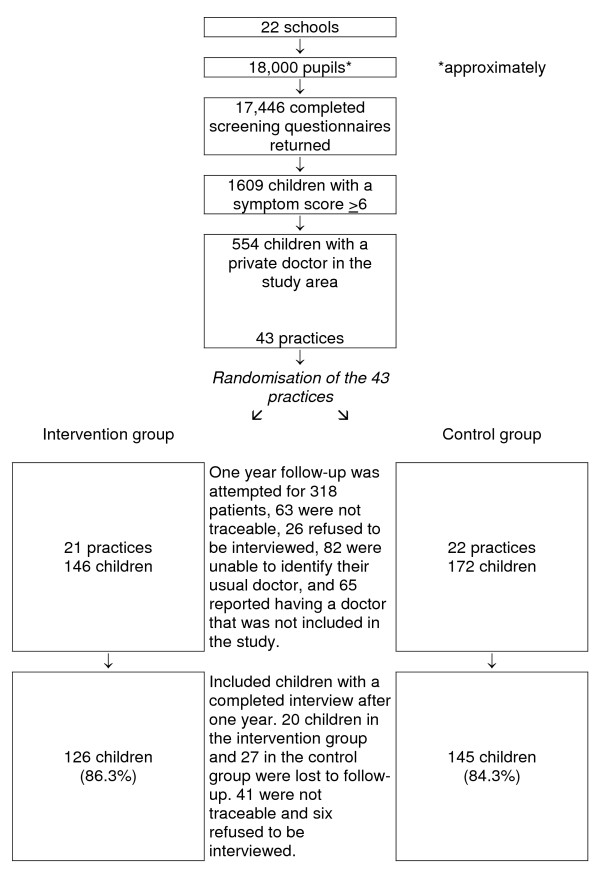
Trial flow diagram.